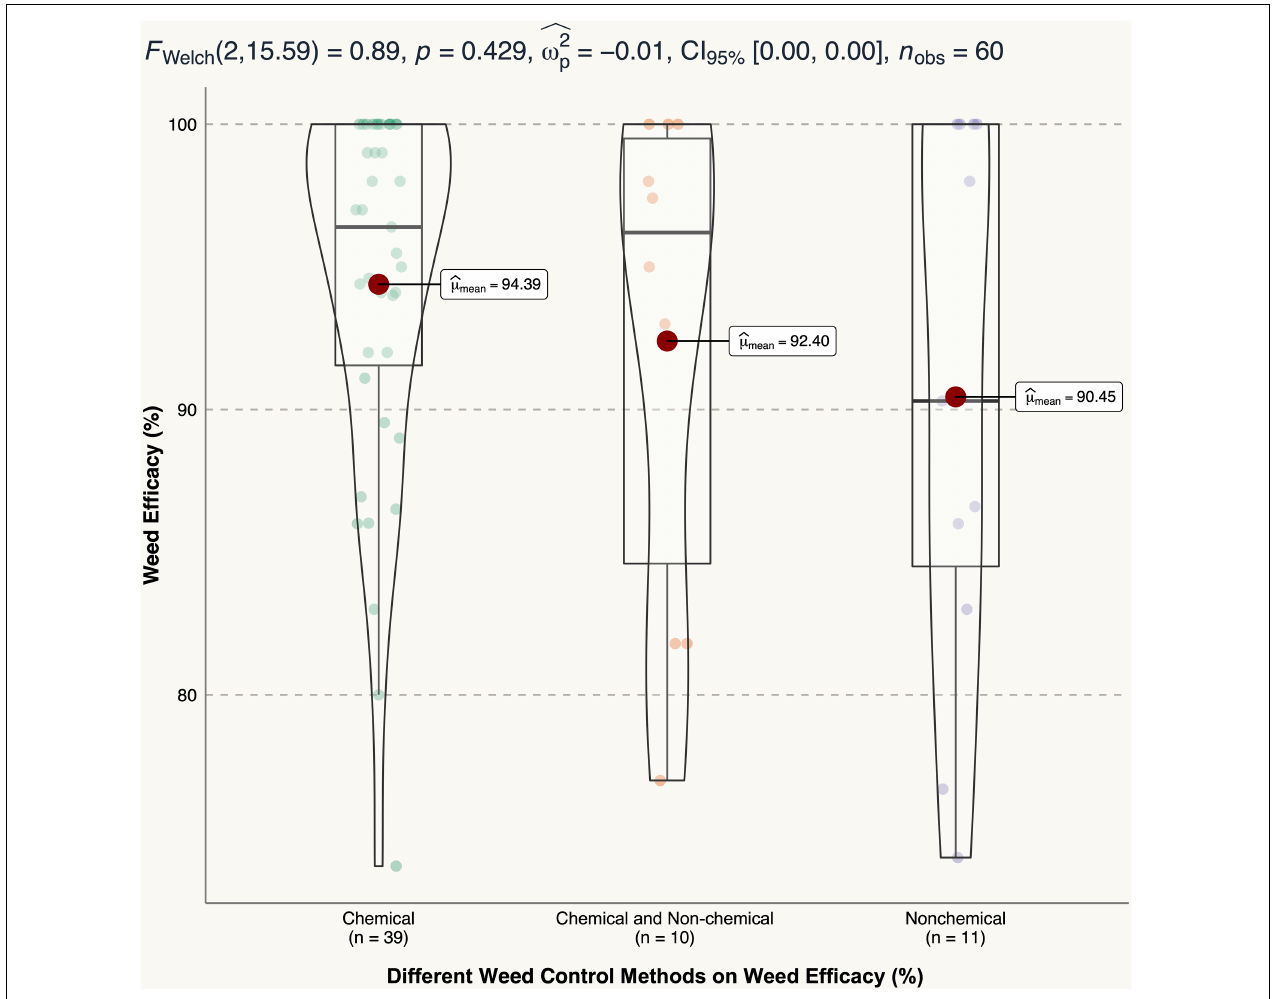
FIGURE 5 | Different weed control methods (chemical, chemical and non-chemical combined, and non-chemical) effects on weed control